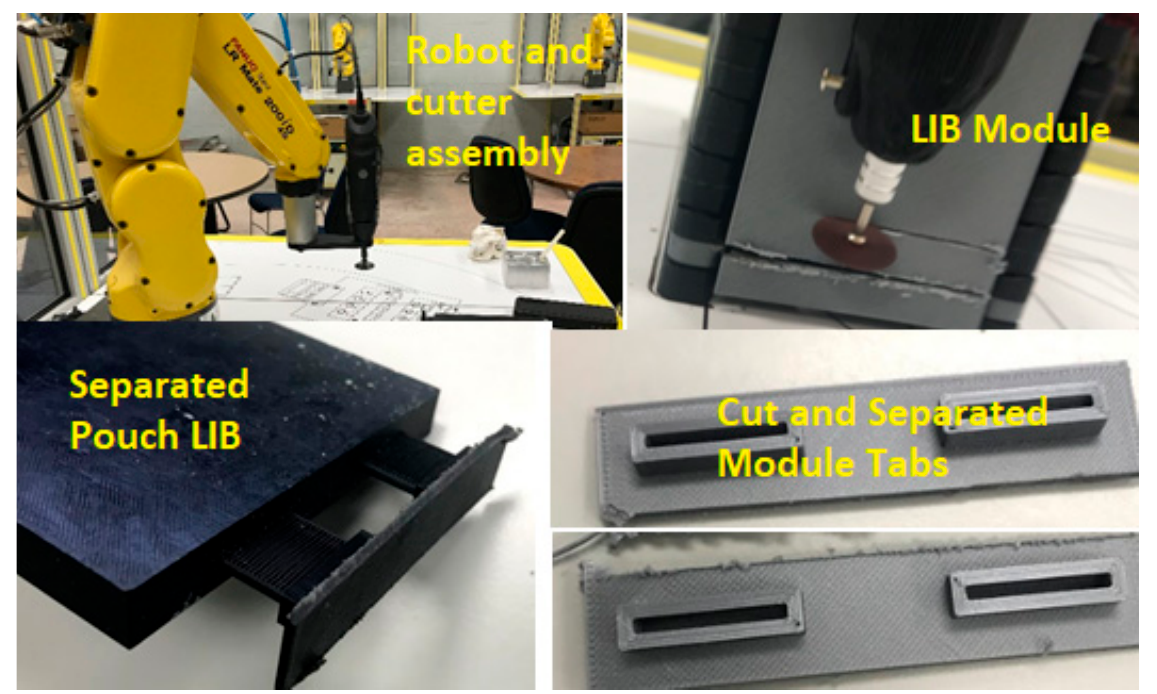
Figure 9. The results of the implementation of the work experimentally.